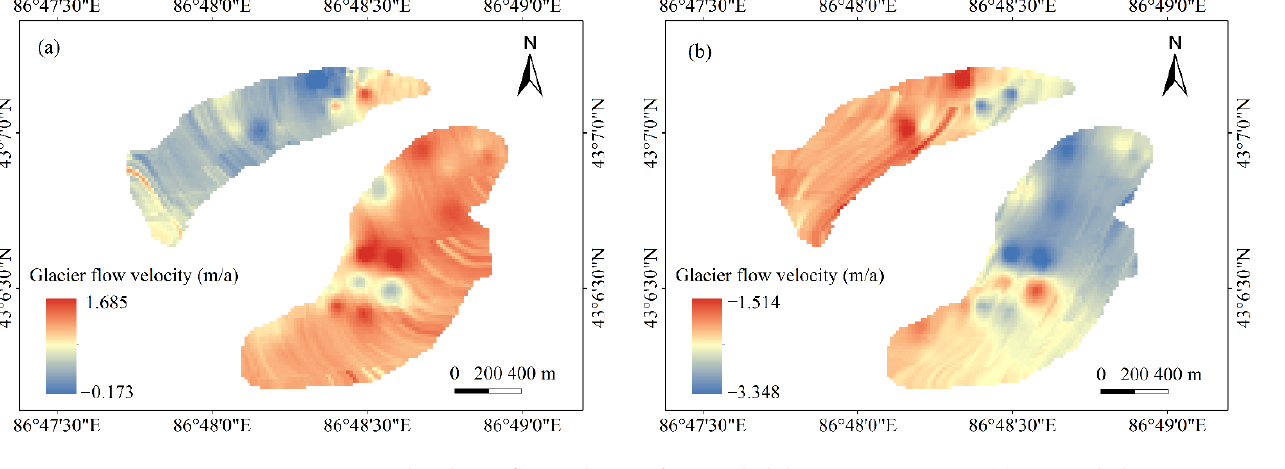
Figure 6. The glacier flow velocity of azimuthal direction 2016 – 2017: ( a ) Azimuthal measurements from the ascending tracks; ( b ) Azimuthal measurements from the descending tracks.